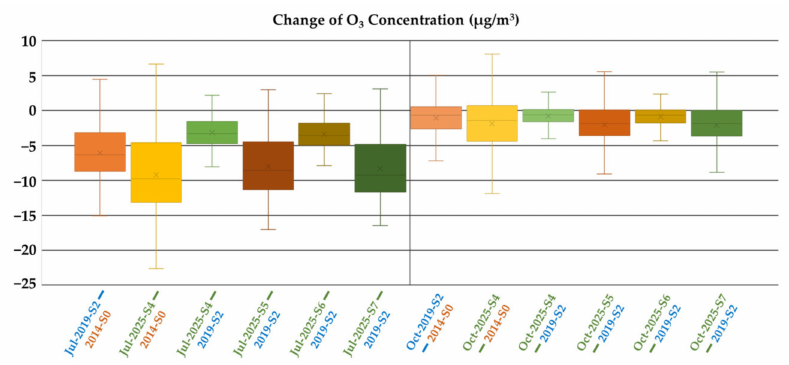
Figure 7. Changes in O 3 concentrations between six pairs of